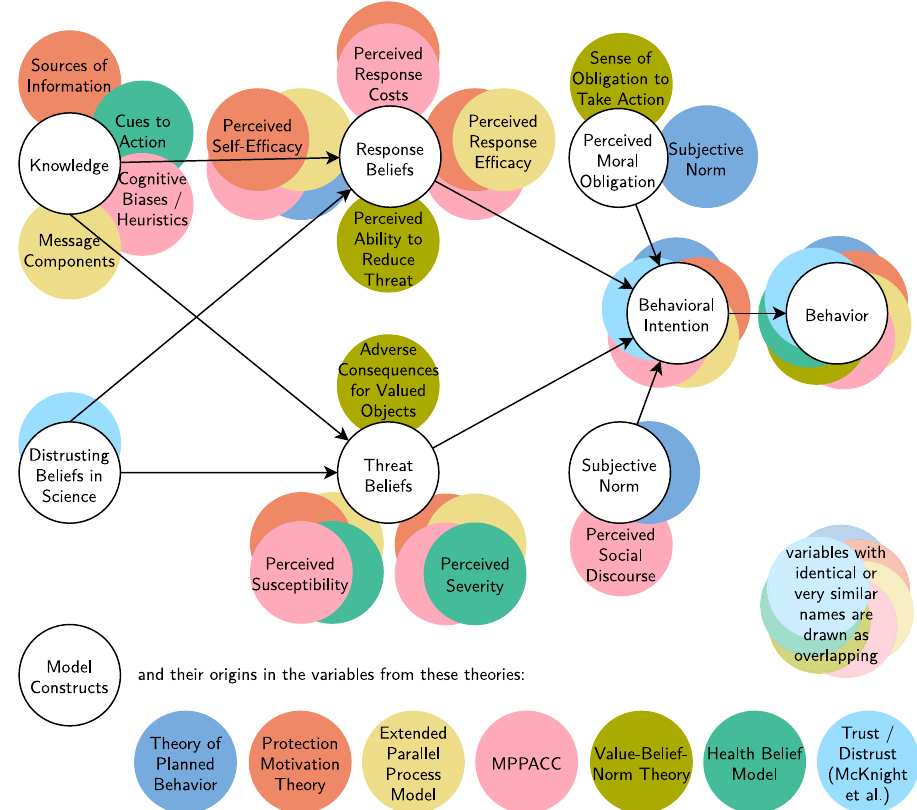
Fig. 1 Synthesised model of in fl uence. The constructs in the theoretical model underlying this study with their origins in different existing behavioural